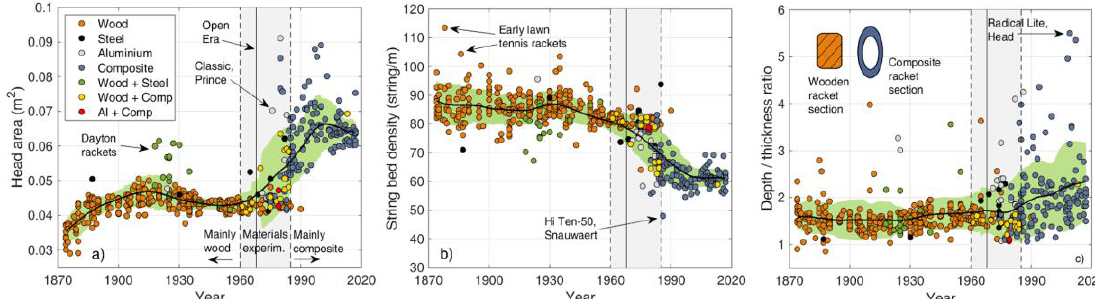
Figure 5. Change in geometry of tennis rackets from 1870s; ( a ) estimated head area; ( b ) string bed density and ( c ) the ratio between frame depth and thickness.